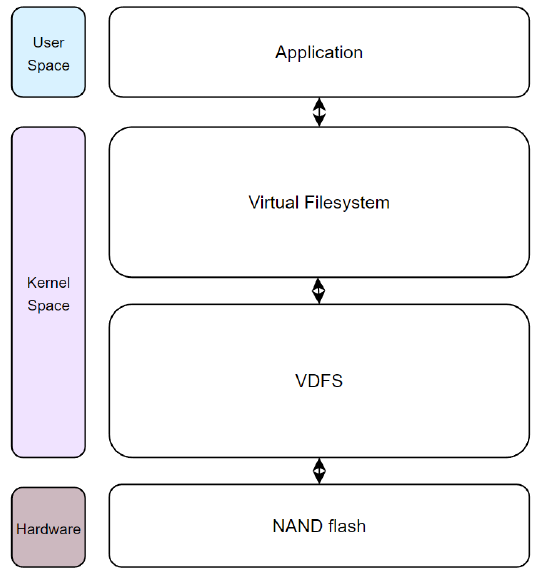
Figure 1. VDFS architecture on Tizen.